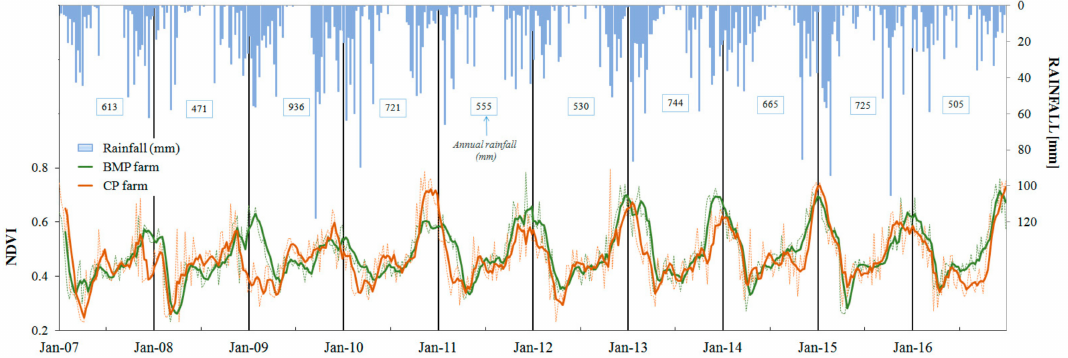
Figure 2. Rainfall data and Modis NDVI time-series used in the